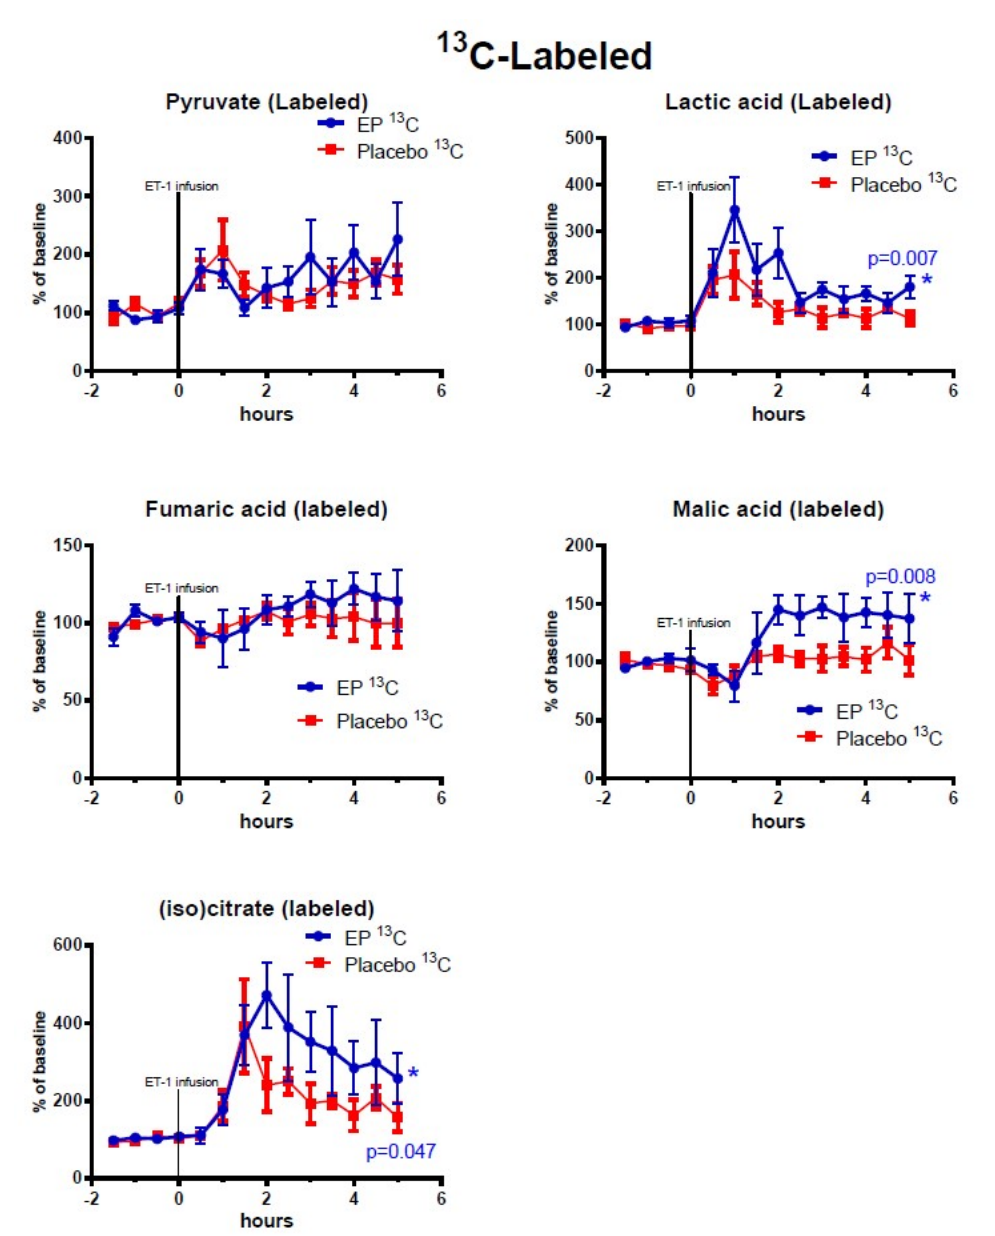
Figure 3. Changes of 13 C-labeled metabolites in ipsilateral striatum after ethyl pyruvate (EP) and placebo treatment. Vasoconstriction of the medial cerebral artery (MCA) was induced by ET-1 infusion (150 pmol/15 µL/15 min) starting at time = 0 h. Blue symbols and line indicate data for rats treated with EP immediately after ET-1 infusion ( n = 5). Red symbols and line indicate data for control rats (placebo treatment after ET-1, n = 6). Metabolite data are expressed as mean ± SEM of percentage change of each rat’s own baseline.